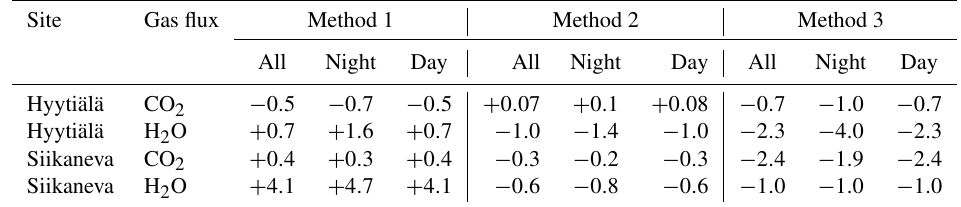
Table 3. Relative difference between the mean CO 2 and H 2 O fluxes obtained with the different correction methods ( ( cor-ref )/ ref · 100%). Fluxes corrected with Method 4 were used as a reference for the other three methods. All values are in per cent